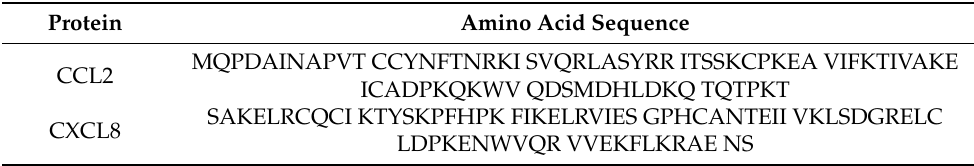
Table 3. Amino acid sequences of the recombinantly expressed chemokines used in this study. Protein Amino Acid